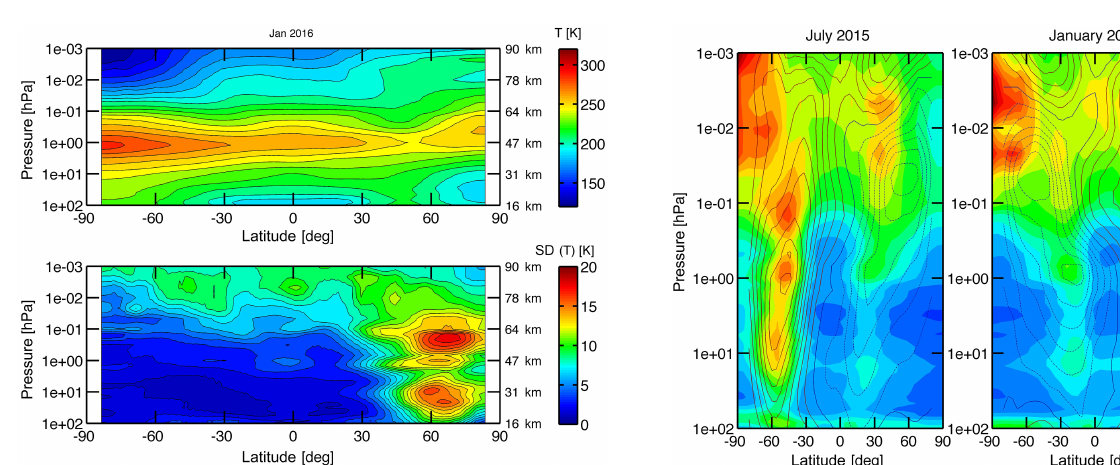
Figure 4. Monthly zonal mean of the standard deviation in temper- ature (SD( T )) as retrieved from level-2 data of the satellite exper- iment Aura/MLS. The standard deviation is determined from five consecutive measurement points of Aura/MLS (details are given in the text). SD( T ) can be regarded as the mean amplitude of the inertia-gravity waves. The left-hand side panel is the result for July 2015 while the right-hand side shows the result for January 2016. The contour lines show the SPARC climatology of zonal wind. Solid contour lines belong to positive eastward winds ( ≥ 0ms − 1 ) while dashed lines are negative eastward winds. The step size is 10ms − 1